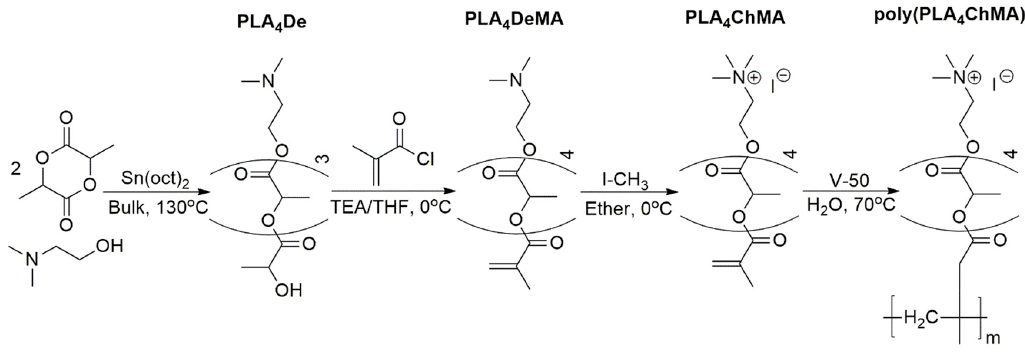
Figure 1. Mechanism to synthesize poly(PLA 4 ChMA) [19].